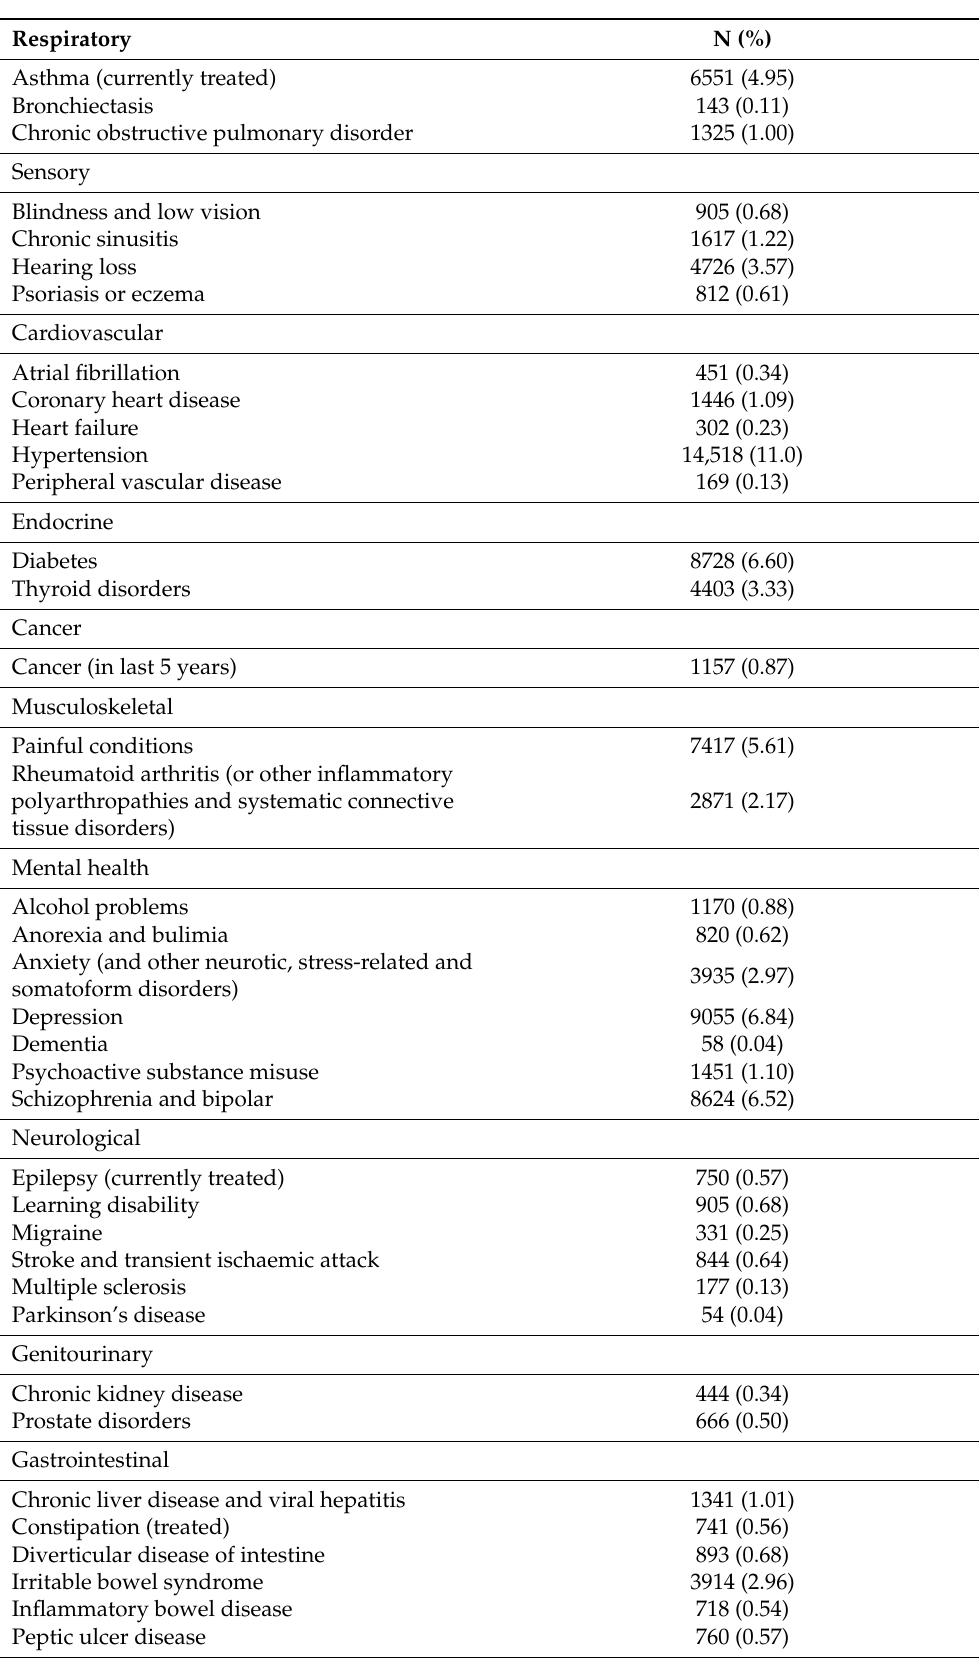
Table A2. The 38 long-term conditions grouped by 10 bodily systems and their distribution across the study cohort (N =